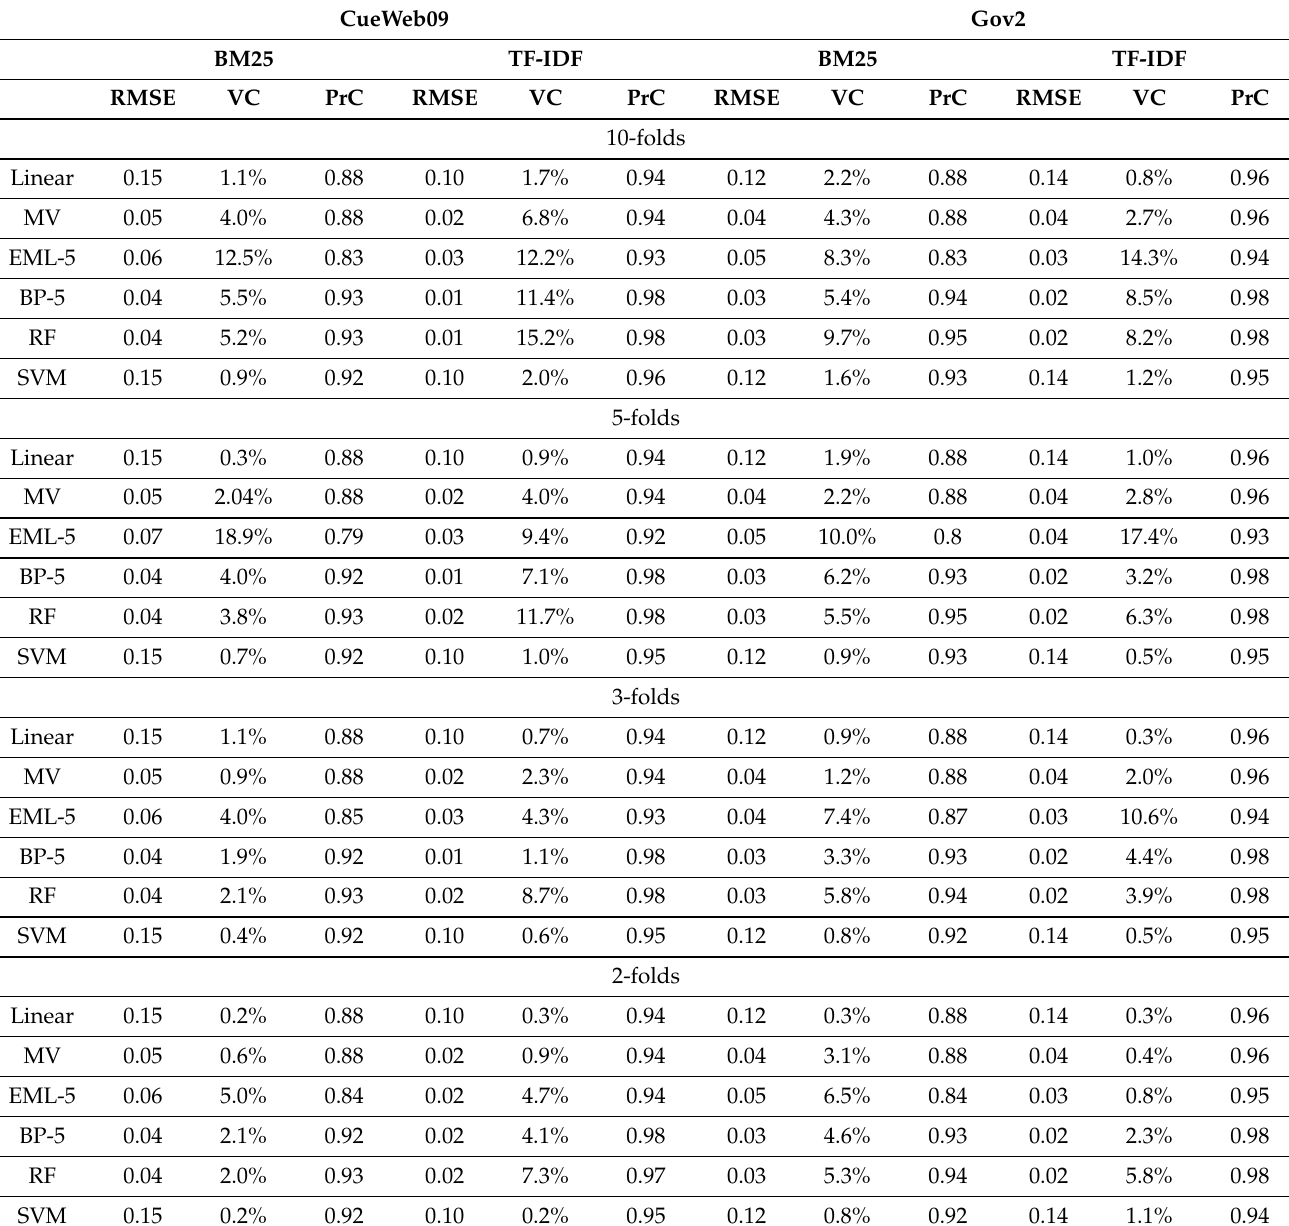
Table 3. Accuracy obtained by the proposed DFT-based query running time prediction algorithm using different machine learning methods.